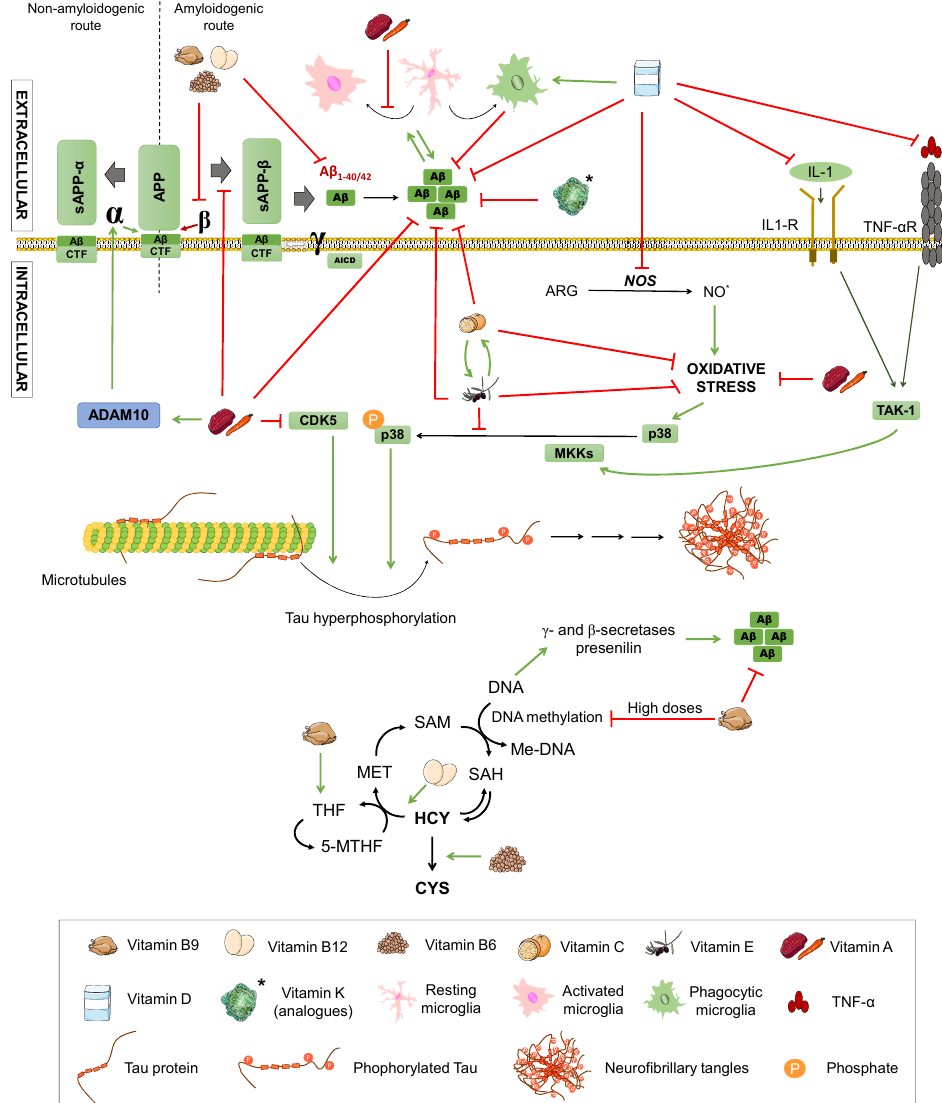
Figure 5. Effects of vitamins on Alzheimer’s disease. Effect of different vitamins on A β and Tau pathology, inflammation, and oxidative stress. ARG: arginine. NO: nitric oxide. TNF α : Tumour Necrosis Factor α . TNF- α R: TNF α receptor. IL-1: interleukin-1. IL-1R: IL-1 receptor. TAK1: transforming growth factor beta-activated kinase 1. P38: P38 mitogen-activated protein kinases. MKK4: Mitogen-Activated Protein Kinase Kinase 4. CDK5: cyclin-dependent kinase 5. APP: amyloid-beta precursor protein. sAPP α : soluble α -APP. sAPP β : soluble β -APP. ADAM10: ADAM Metallopeptidase Domain 10. CTF: carboxy-terminal fragment. AICD: APP intracellular domain. Homocysteine metabolic pathway. MET: methionine. SAM: S-adenosylmethionine. SAH: S-adenosylhomocysteine. HCY: homocysteine. CYS: cysteine. THF: tetrahydrofolate. 5-MTHF: 5-methyltetrahydrofolate. Met-DNA: methylated-DNA. Green arrows represent activation. Red truncated arrows represent